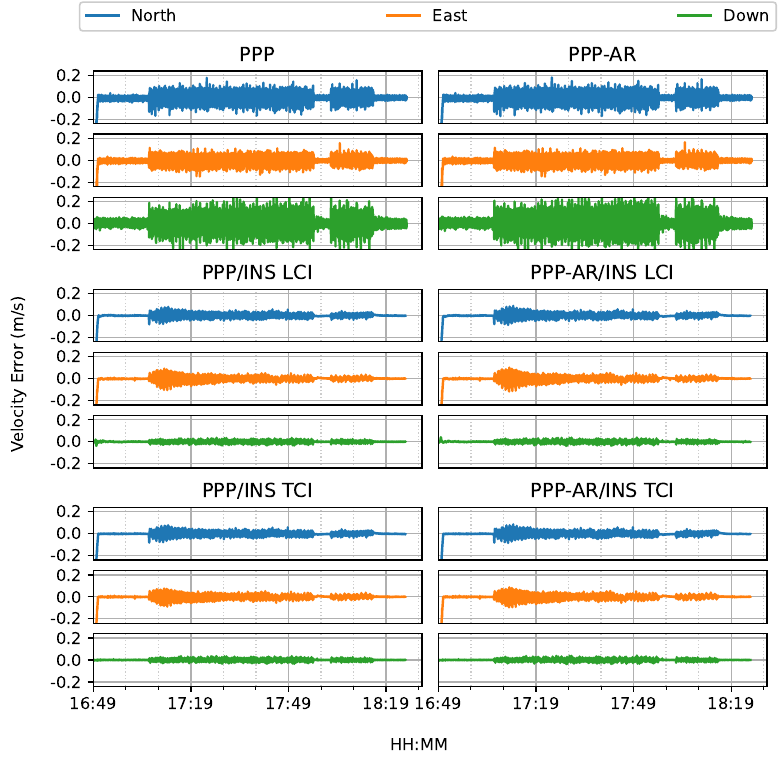
Figure 10. Velocity errors of PPP/INS train positioning test on 7 March